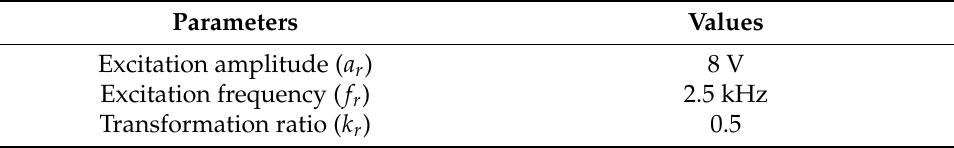
Table 1. Simulation parameters of the resolver